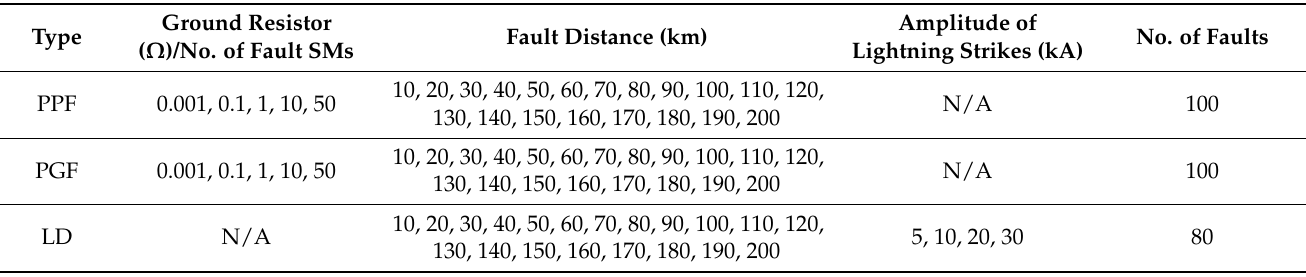
Table 2. Experiment in different